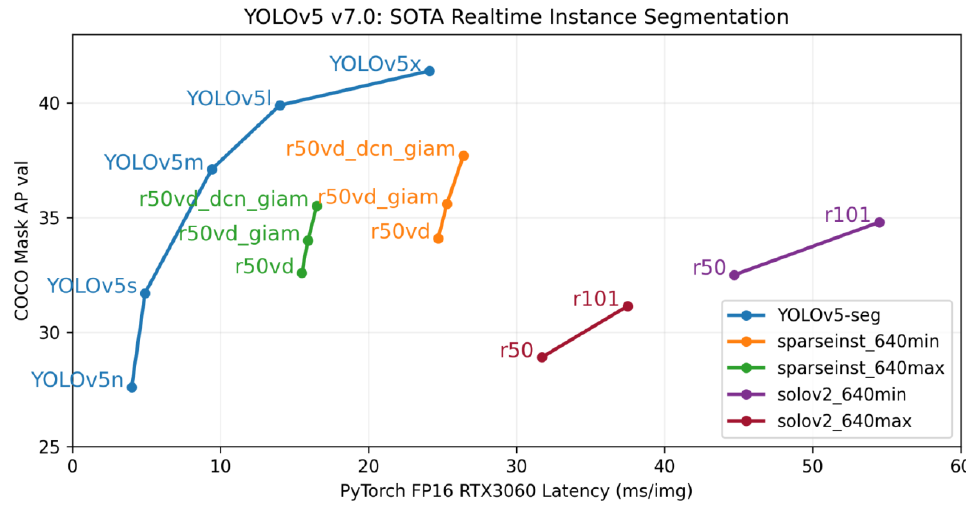
Figure 3. YOLOv5 SOTA Real-Time Instance Segmentation.